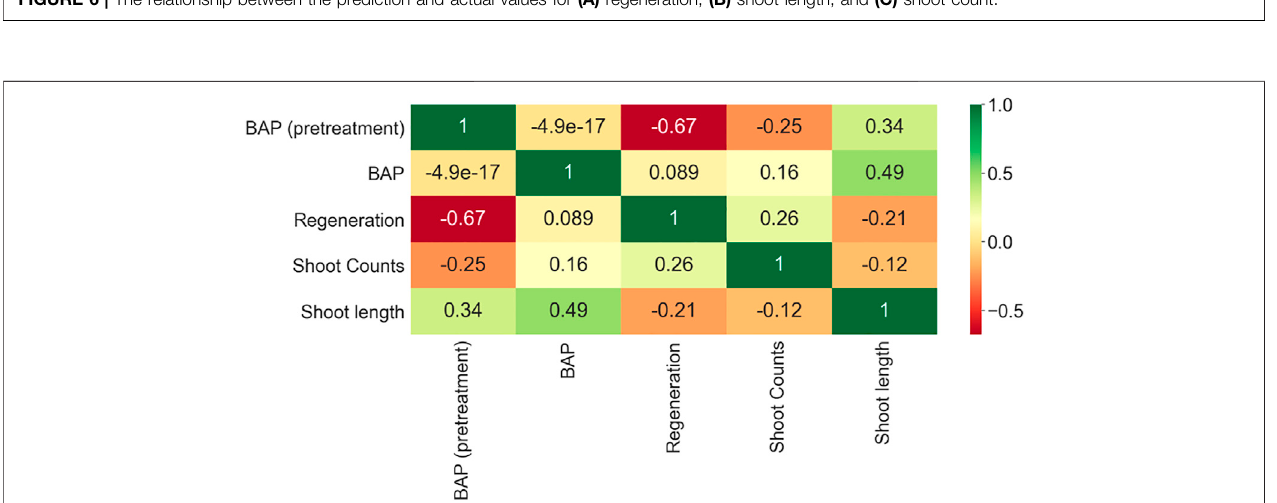
FIGURE 6 | The relationship between the prediction and actual values for (A) regeneration, (B) shoot length, and (C) shoot count.